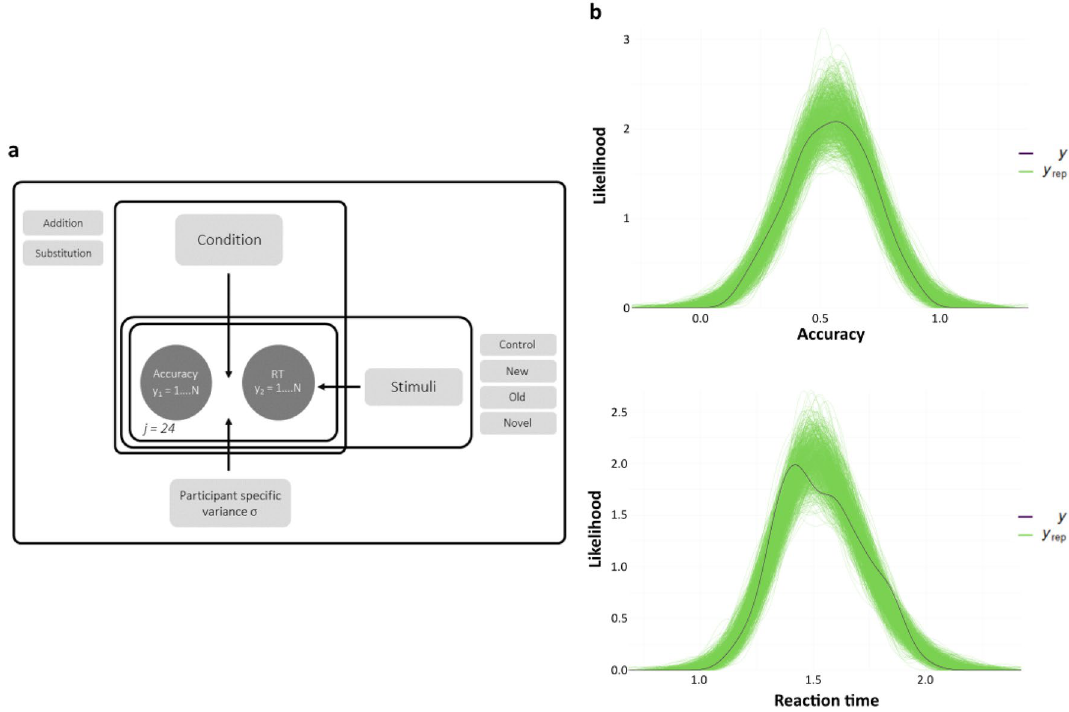
Figure 4. Bayesian multivariate regression. ( a ) Graphical illustration of the model. Both response times and memory accuracy were modelled to be drawn from a multivariate Gaussian distribution. Parameters of the two categorical predictors (Stimuli, Condition) and their interaction term were drawn from a noninformative Student t prior. Their slopes were allowed to vary across the group j (participants, n = 24), capturing the participant-level variability. ( b ) Posterior predictive densities of accuracy (top) and reaction times (bottom) depicting a good model fit. Dark lines represent the observed data distribution ( y ) of the two response variables, while the green lines represent the replicated (simulated) draws ( y rep ) from the model’s posterior predictive